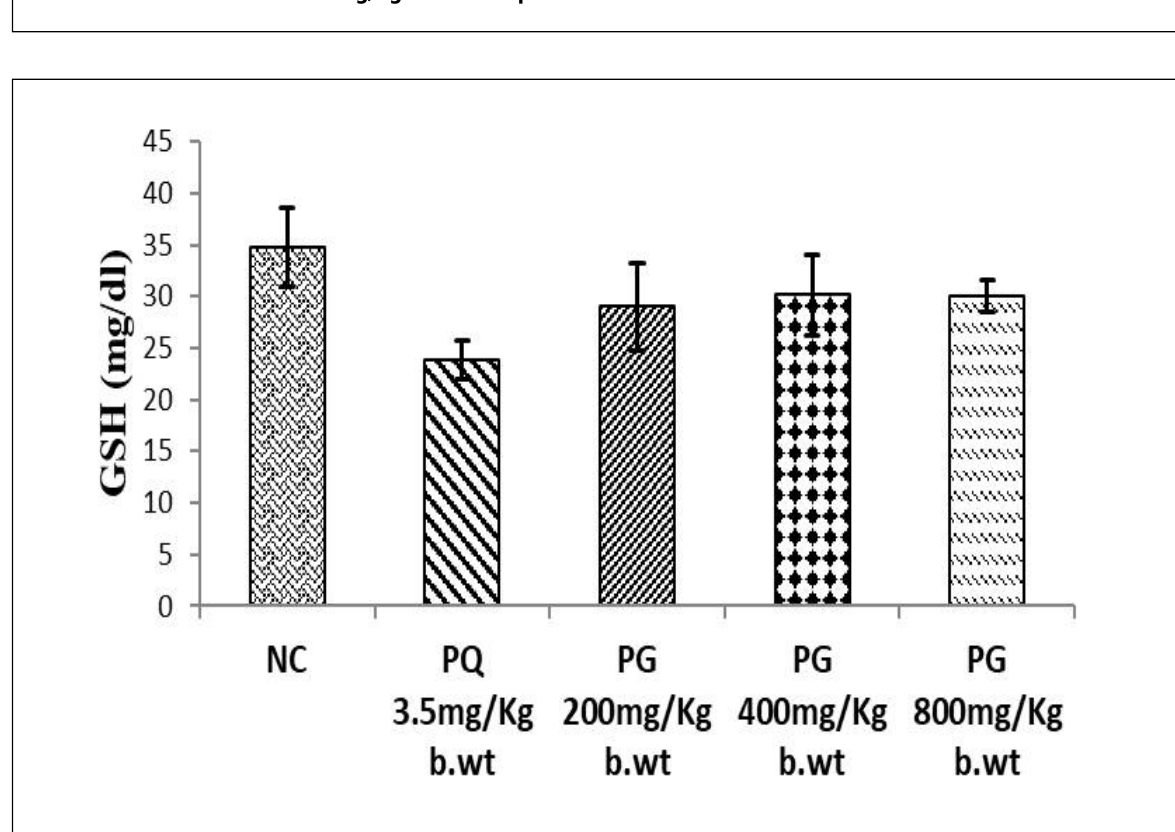
Figure 9: Effect of Psidium guajava leaf extract administration on serum glutathione concentration of male Wistar albino rats administered 3.5 mg/kg b.wt.